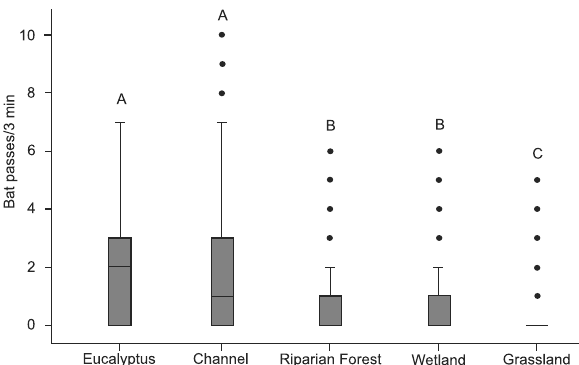
Figure 8. Box plot of the number of bat passes/3 min recorded with a bat detector in each habitat type, from April 2009 to March 2010, in the grasslands of southernmost Brazil. Different letters indicate significant differences at the 0.005 probability level (with Bonferroni